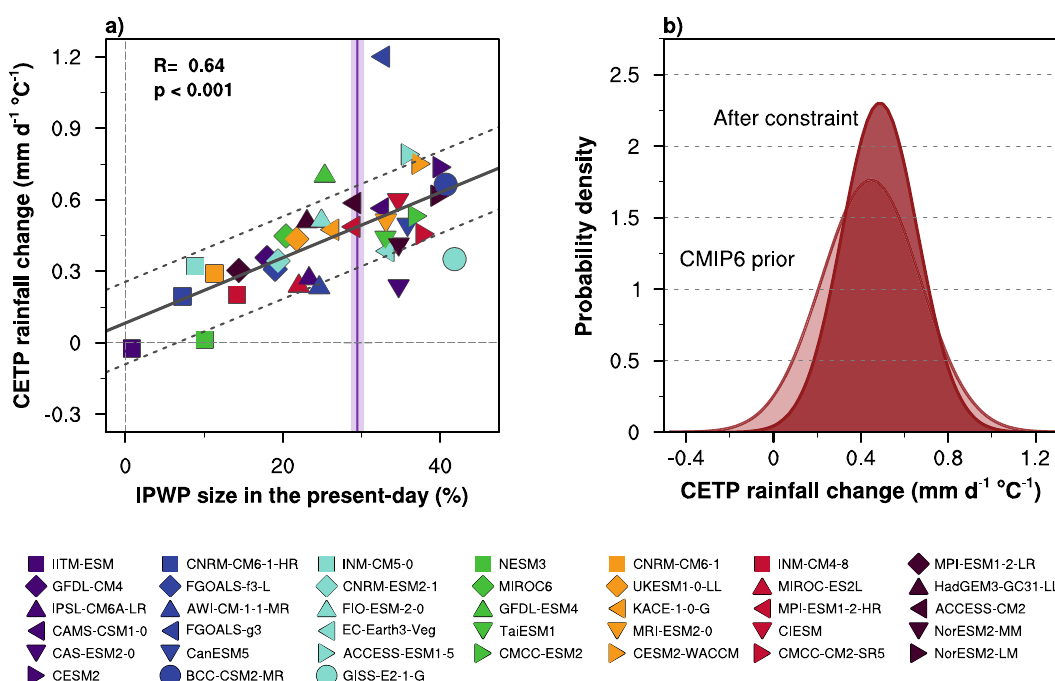
Fig. 4 Emergent constraints on the central-to-eastern tropical Paci fi c (CETP) precipitation changes in CMIP6. a Projected precipitation changes in the CETP under SSP5-8.5 across the CMIP6 models versus the Indo-Paci fi c warm pool (IPWP) size in the present-day (1950 – 1999). The solid gray line follows the linear regression of 38 CMIP6 models, while the dashed gray lines indicate prediction errors with one standard deviation (68% con fi dence intervals). A solid purple line (shading) indicates the average (one standard deviation) of the observed IPWP size among three datasets: HadISST, ERSSTv5, and COBE- SST2. b Probability density functions for the projected precipitation changes in the CETP under SSP5-8.5, before ( “ CMIP6 prior ” , transparent) and after ( “ after constraint ” , opaque) the emergent constraint is applied.